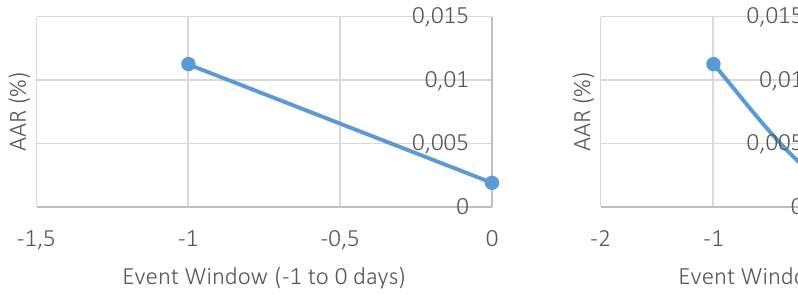
Figure 6. Average abnormal returns for the period of (–5, –1) days